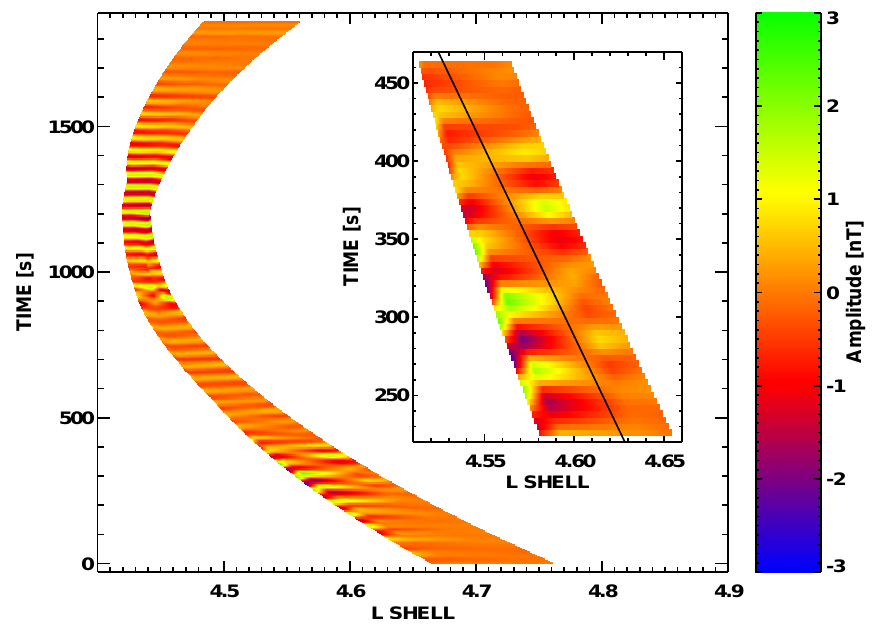
Fig. 9. Range-time-intensity plot of the 7 August 2003, 07:49–08:16UT magnetic field fluctuations of the b r component. The ordinate is the time axis with T =0s corresponding to 07:49UT. The black line in the inlet corresponds to zero of wave amplitude indicating the apparent phase motion.